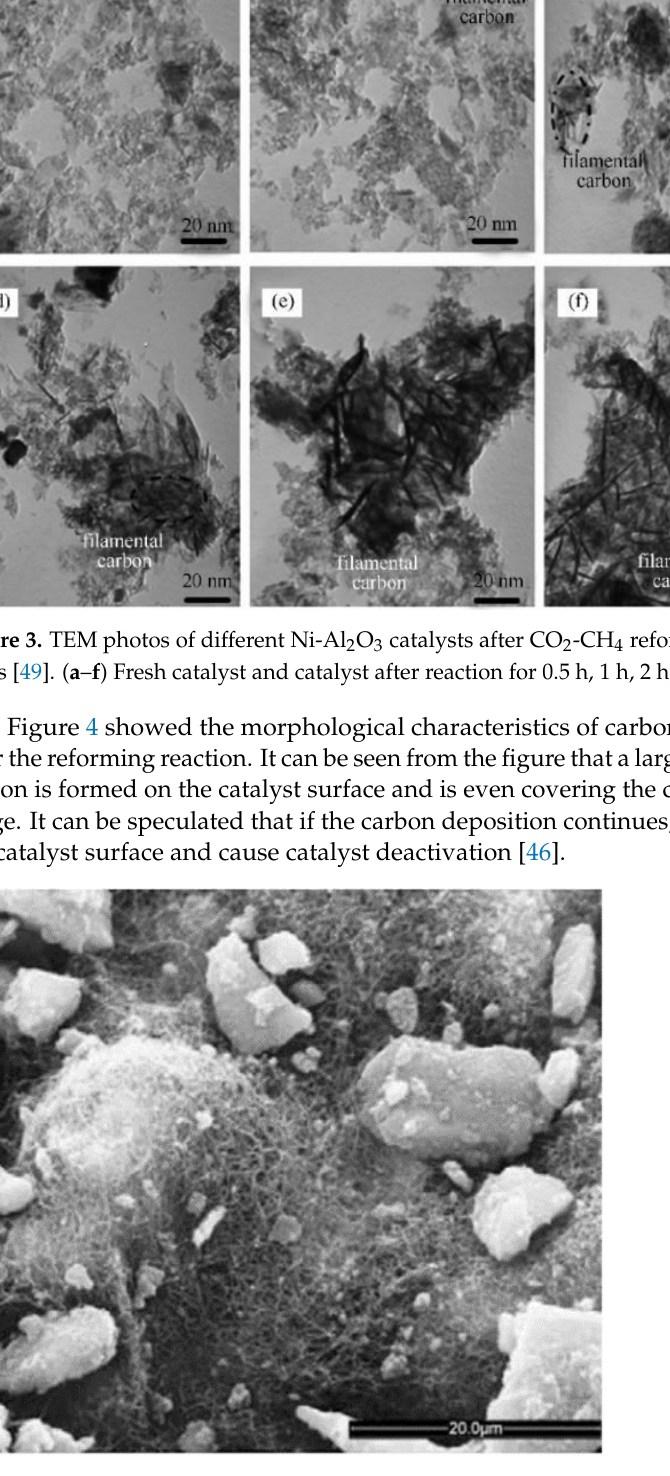
Figure 4. SEM of CO 2 -CH 4 reforming reaction after 20 h [46].